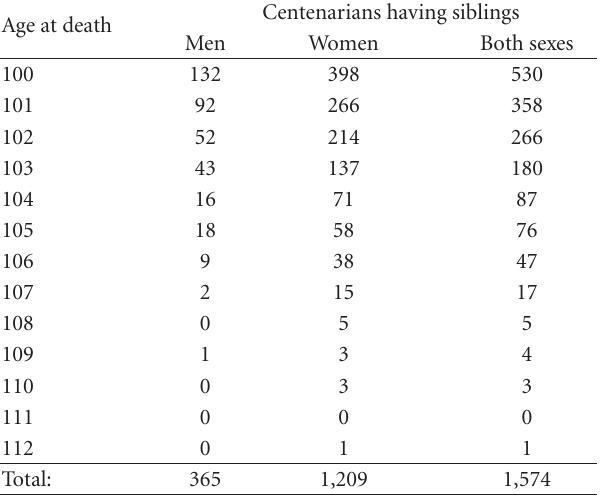
Table 2: Distribution of centenarians born in 1880–1895, by age at